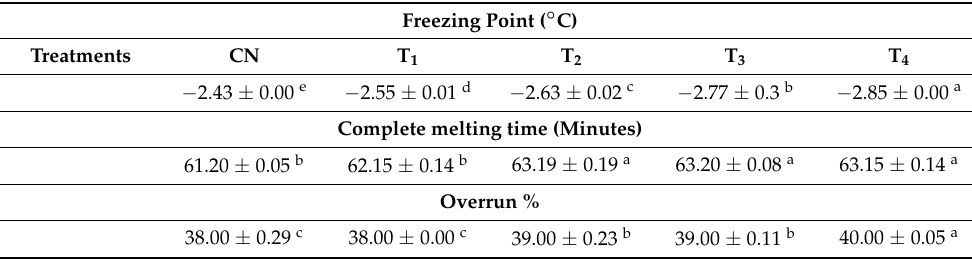
Table 4. Changes in freezing point, melting rate, and overrun of fresh frozen yoghurt affected by adding substantial ratios of JATP during cold